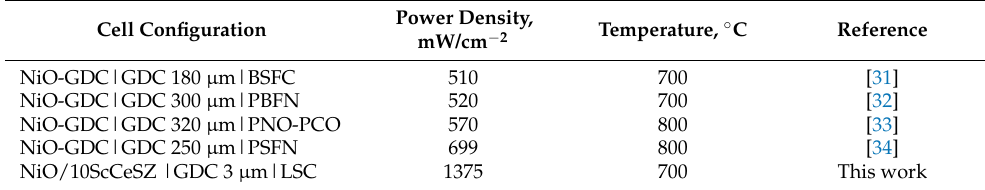
Table 1. Power density values of intermediate-temperature SOFCs with the GDC